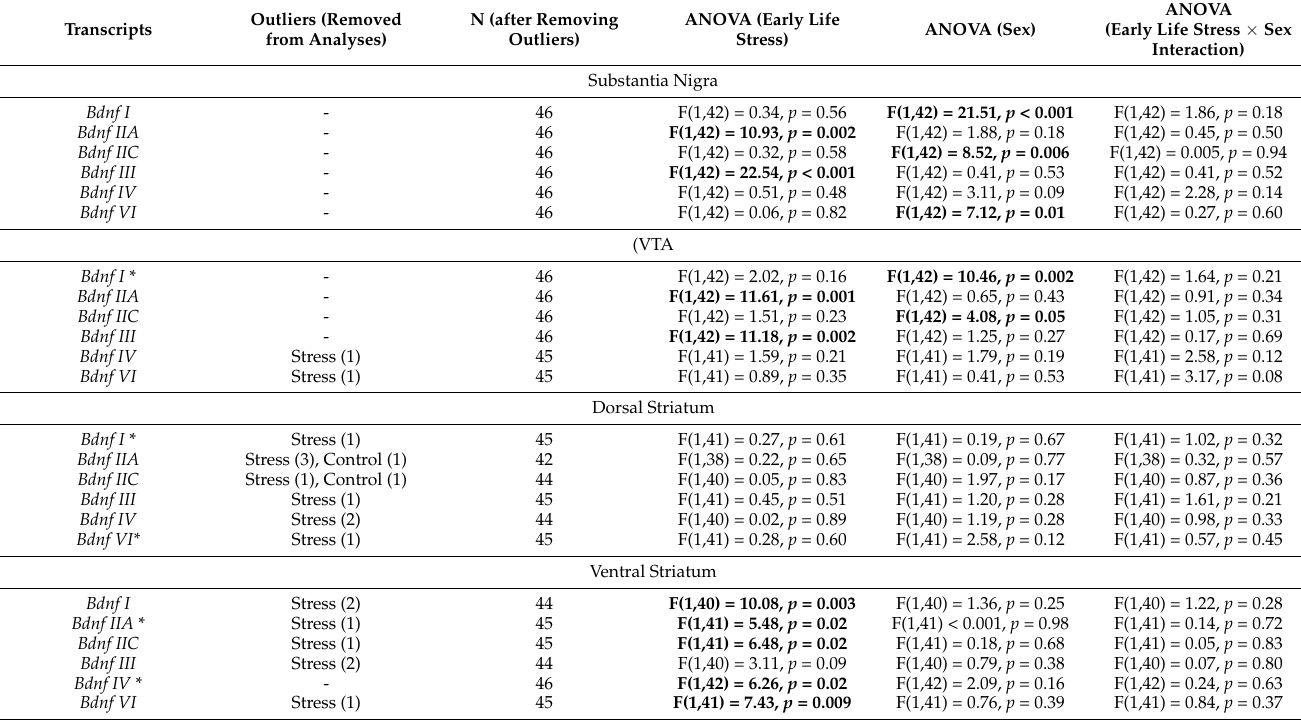
Table 2. Two-way ANOVA showing main effects of sex, treatment and interaction between sex and treatment on Bdnf transcript levels in the ventral striatum of 22 control and 24 maternally separated rodents. Asterisks (*) indicate genes whose log-transformed data were used for statistical analysis. Bold type indicates statistically significant